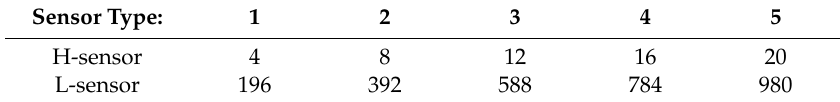
Table 2. Proportion of two types of nodes in heterogeneous wireless sensor networks (HWSNs). Sensor Type: